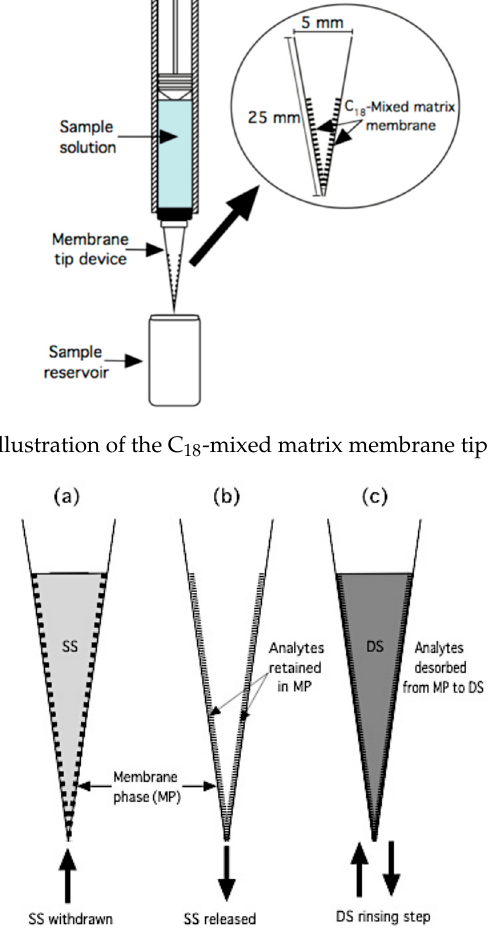
Figure 2. Expanded view of dynamic microextraction. ( a ) The sample solution (SS) is continuously withdrawn into the membrane tip for analyte adsorption. ( b ) The withdrawn SS is dispensed from the membrane tip into the sample vial, with the analytes retained in the membrane phase (MP). ( c ) The desorption solvent (DS) is continuously flushed in the membrane tip ten times, and the analytes are transferred rapidly from the MP to the DS. Table 1. Finalized multiple reaction monitoring (MRM) transition by ultra-performance